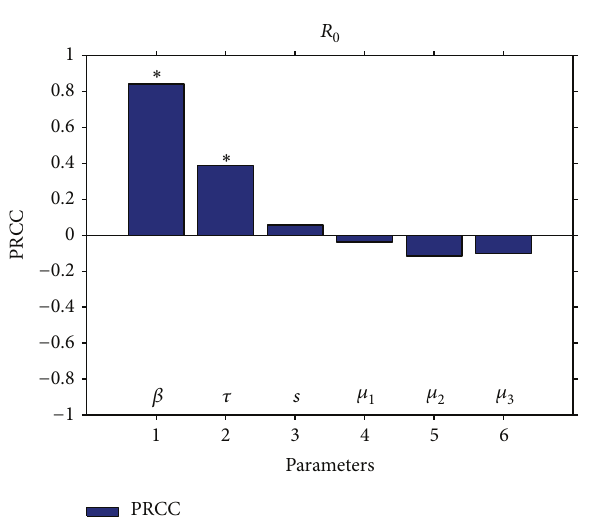
𝜏 = 0.03 , 𝜇 = 0.09 , and 𝑅 = 1.1556 > 1 . All solutions 3 0 converge to the chronic infection equilibrium 𝑃 1 .